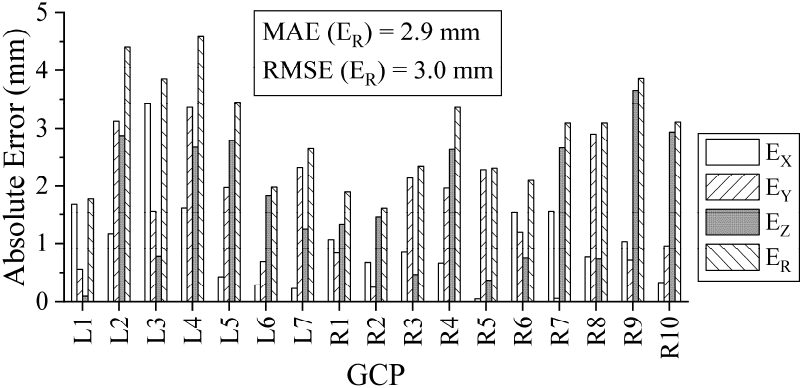
Figure 3. Estimated errors in reproduction of points in a 3D model using SfM, Case Study I. The errors are calculated in model scale.